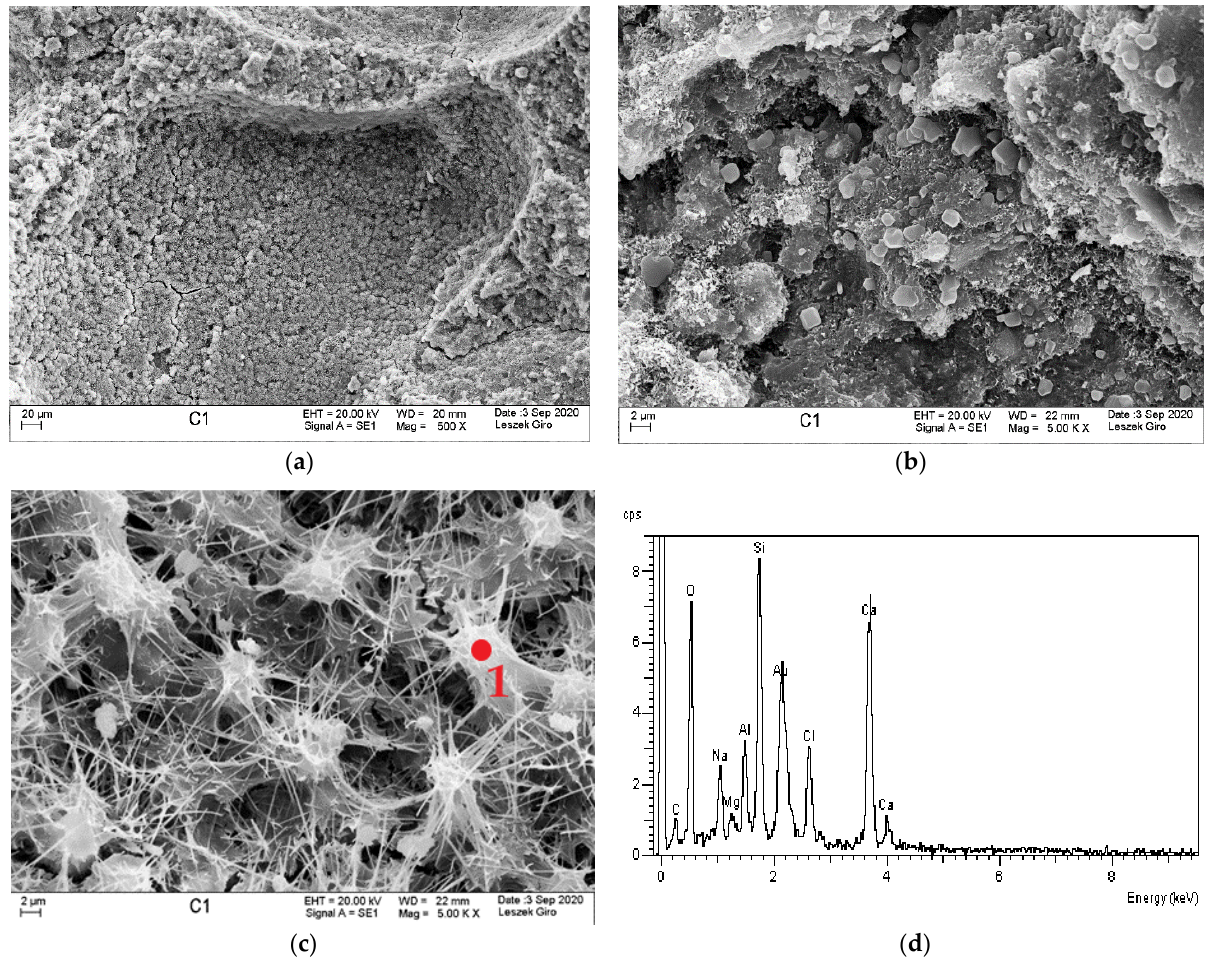
Figure 8. Microstructure of the specimen exposed to chloride ions; visible cracks in the C-S-H phase ( a ); irregular NaCl